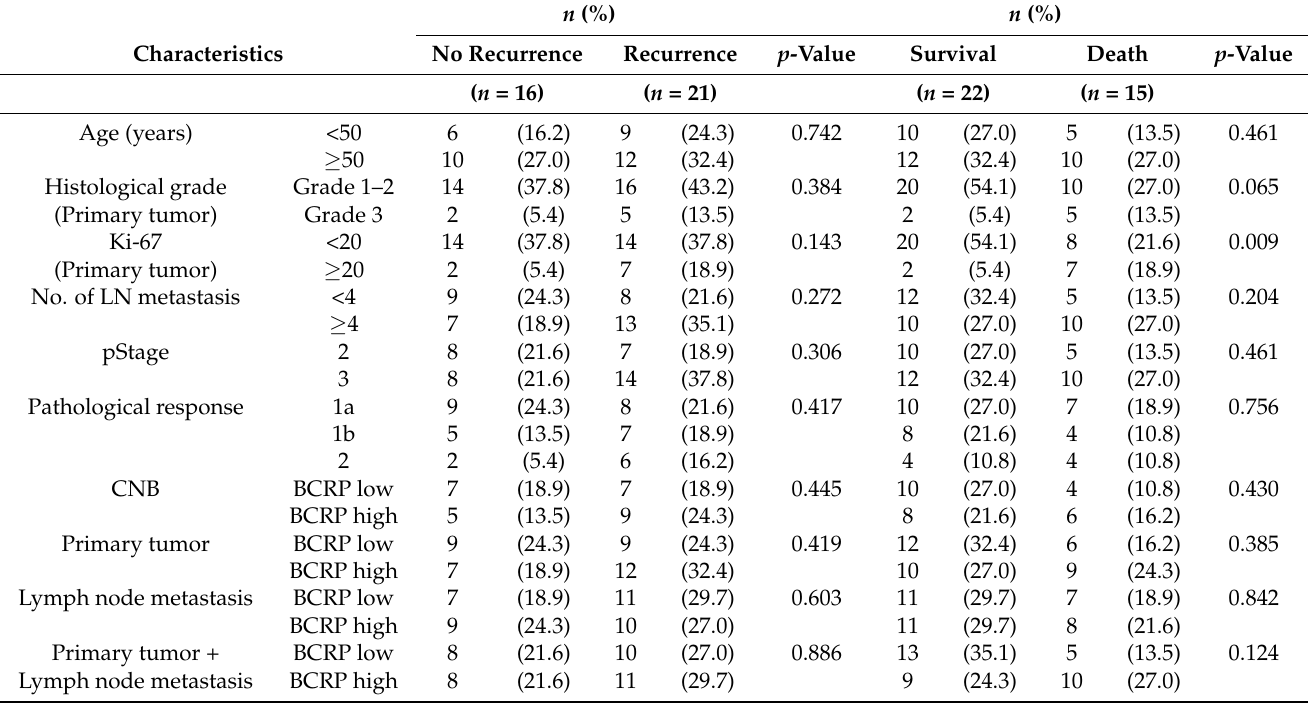
Table 2. Correlations between biological factors and recurrence or survival.